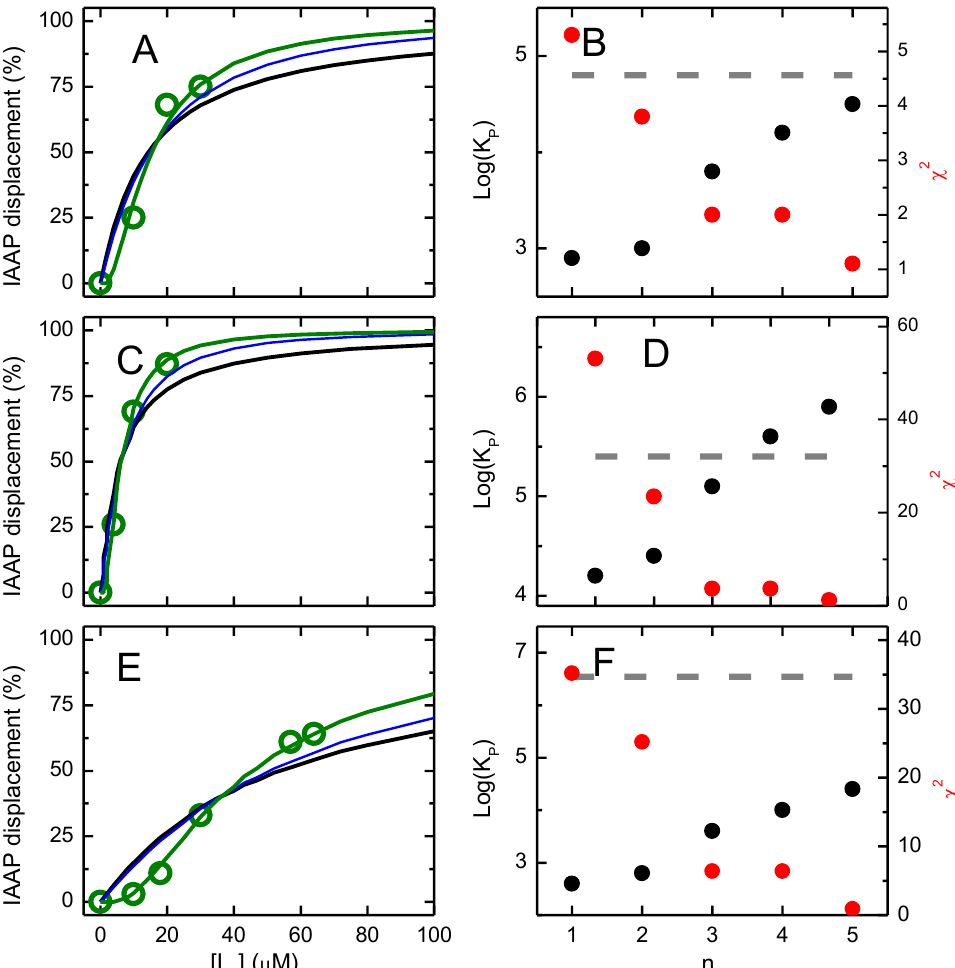
Figure 11. Effect of NBD – C4 (plot A , B ), NBD – C8 (plot C , D ), and NBD – LysoMPE (plot E , F ) on IAAP displacement from P – gp ’s binding pocket considering that IAAP is displaced from P – gp ’s binding pocket when the number of NBD amphiphiles bound (i) is ≥ n−1. The plots on the left show the experimental results ( ) and the best fit of Equation (11) considering different number of binding n n n sites in P – gp ’s binding pocket: = 1 ( ─ ), = 2 ( ─ ), and = 5 ( ─ ). The plots on the right show the effect of the number of binding sites on the quality of the best fit ( χ 2 , ⚫ ) and on the partition coefficient calculated from 1 ( ⚫ ). The partition coefficient between the aqueous phase and P – gp obtained from the partition experiments is also shown ( ).